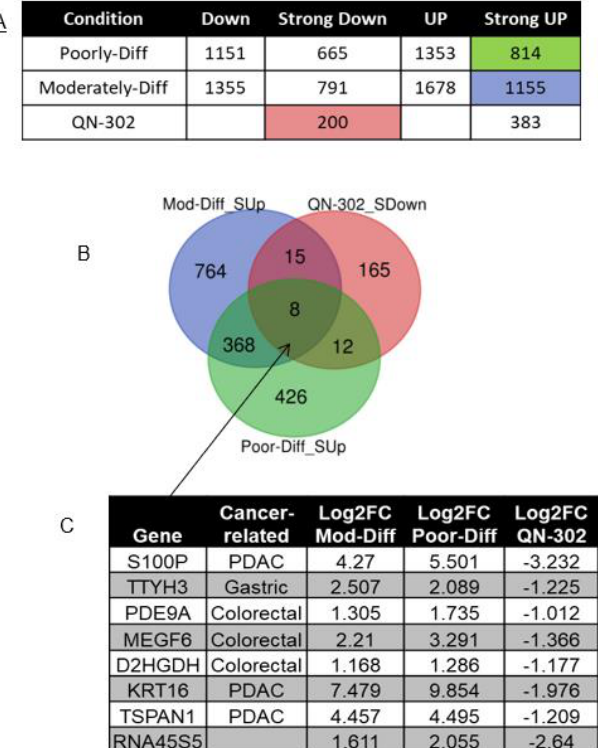
Figure 3. ( A ) Numbers of differentially expressed genes (DEGs) from RNA-seq of PDAC patient samples (poorly or moderately differentiated) versus normal pancreas tissue. DEGs from QN-302 study were added to compare with PDAC data. DEGs were split into four subsets: Down = DEGs with log 2 FC < − 0.5 and FDR < 0.1; Strong Down = DEGs with log 2 FC ≤ − 1 and FDR < 0.05; Up = DEGs with log 2 FC > 0.5 and FDR < 0.1; Strong Up = DEGs with log 2 FC ≥ 1 and FDR < 0.05. ( B ) Venn plot showing numbers of upregulated genes in PDAC patients intersected with genes downregulated by QN-302 when treating PDAC MIA PaCa-2 cells for 24h. ( C ) List of the common upregulated genes in poorly and moderately differentiated PDAC patients, potential targets for QN-302.